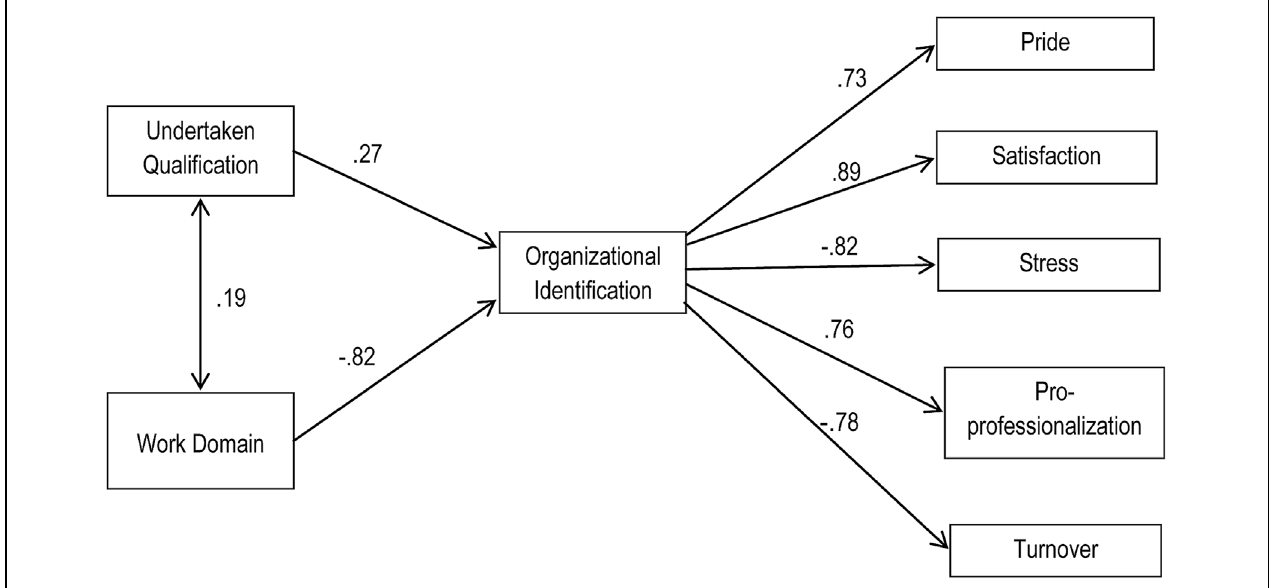
FIGURE 2 | The effects of undertaking a qualification and work domain (residential vs. domiciliary) on motivation and well-being (Model 2, Time 2).